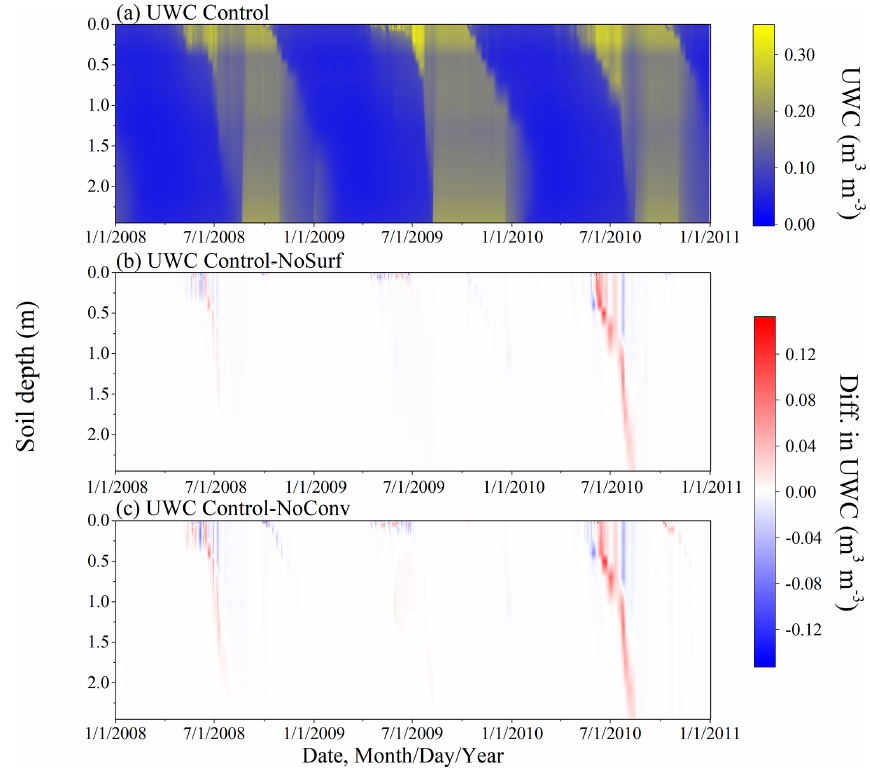
Figure 5. Simulated hourly unfrozen water content (UWC) profiles under the Control scenario (a) , as well as the differences in UWC between the following scenarios: Control–NoSurf (b) and Control–NoConv (c)